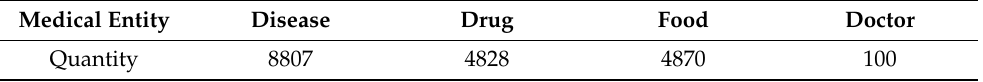
Table 2. Statistical results of medical entities in the online medical